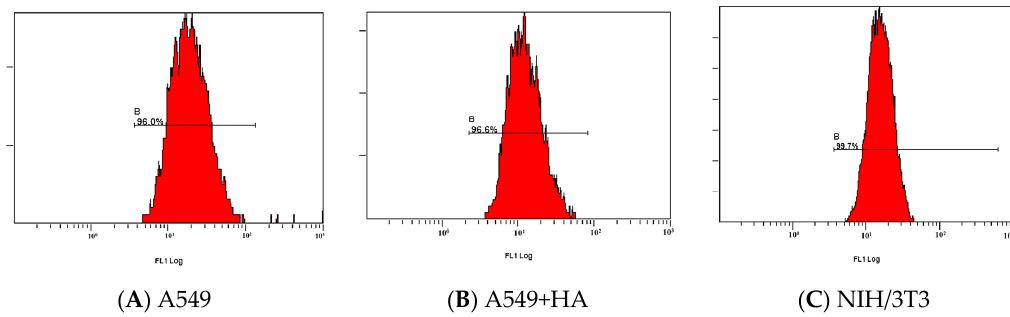
Figure 8. Flow cytometry analysis of the specific endocytosis of fluorescein isothiocyanate isomer I (FITC)-labelled HA internalized by ( A ) A549 cells, ( B ) A549 cells pre-treated for 2 h with free HA